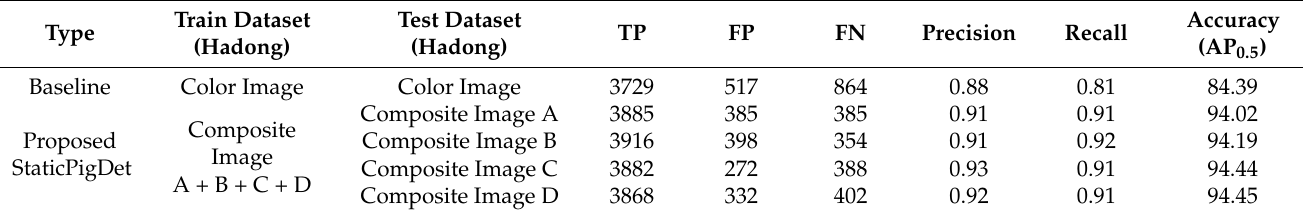
Table 2. Detection accuracy results for Hadong dataset with tinyYOLOv4 [41].